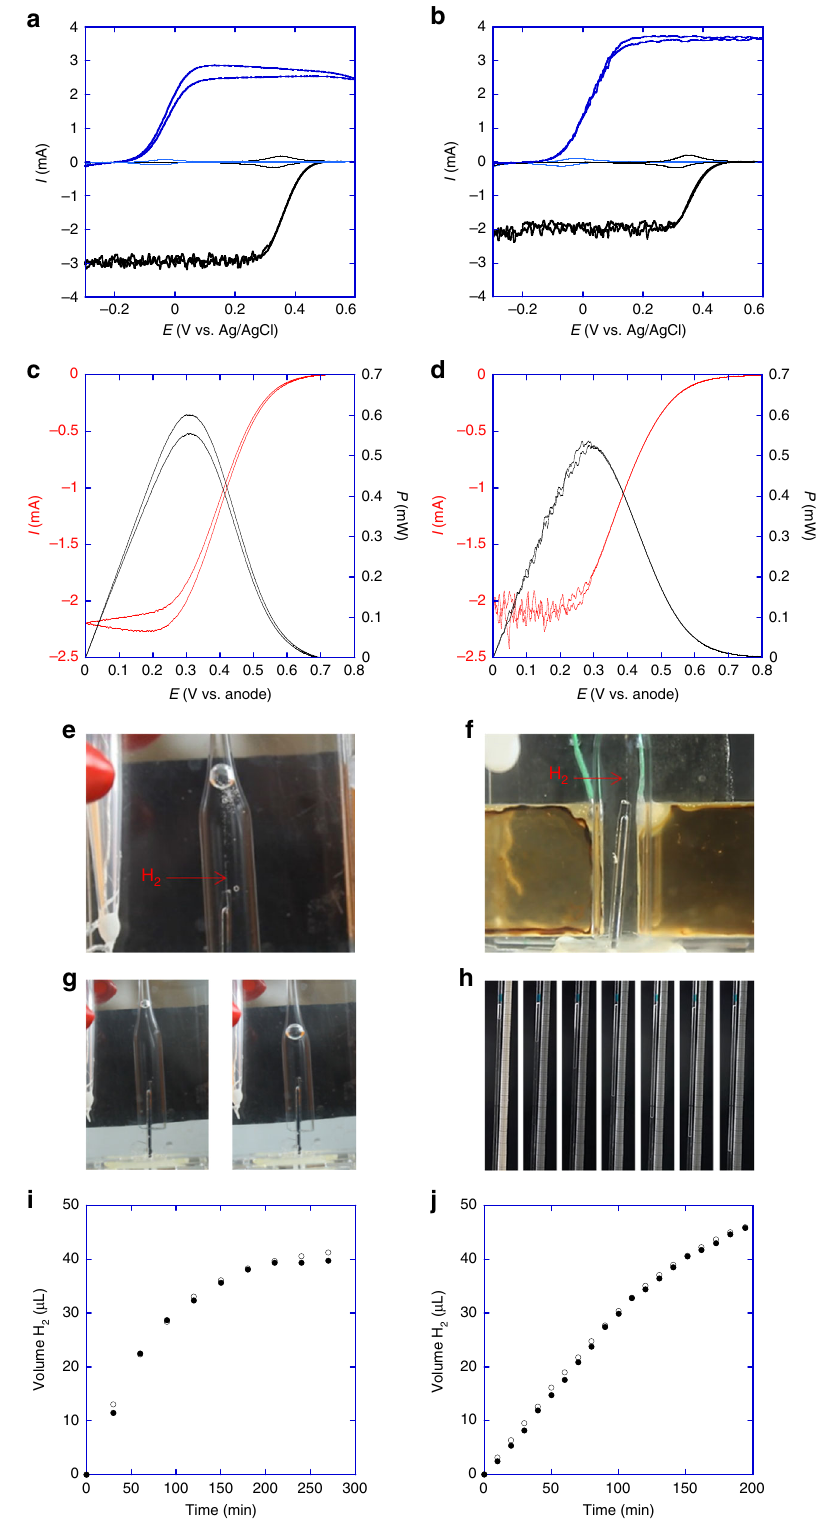
Fig. 3 Examples of experiments of H 2 production powered by glucose/O 2 biofuel cells. The left column presents an experiment with the electrolyser separated from the BFC compartment, while the right column shows results for the BFC and electrolysis running in the same medium. a , b Electrochemical characterization at 37°C of the anode (blue lines) and cathode (black lines) in argon saturated phosphate buffer (thin lines) or in oxygen saturated buffer containing 50mM of glucose (thick lines). Polarization (red lines) and power (black lines) curves of the biofuel cells for c the two-compartment set-up or d the one-compartment con fi guration. e , f are pictures of the H 2 generation at the microelectrode in the two and one compartment case respectively. g , h illustrate the gas collection as a function of time (see Supplementary Movies 1 and 2). For the two-compartment experiment pictures are shown at the start of the reaction and after 4h. For the one-compartment experiment, pictures of the capillary in which the gas is collected are taken every 30min. i , j show the comparison of the H 2 volume measurement (full circles) and the faradaic estimation (open circles) for the two con fi